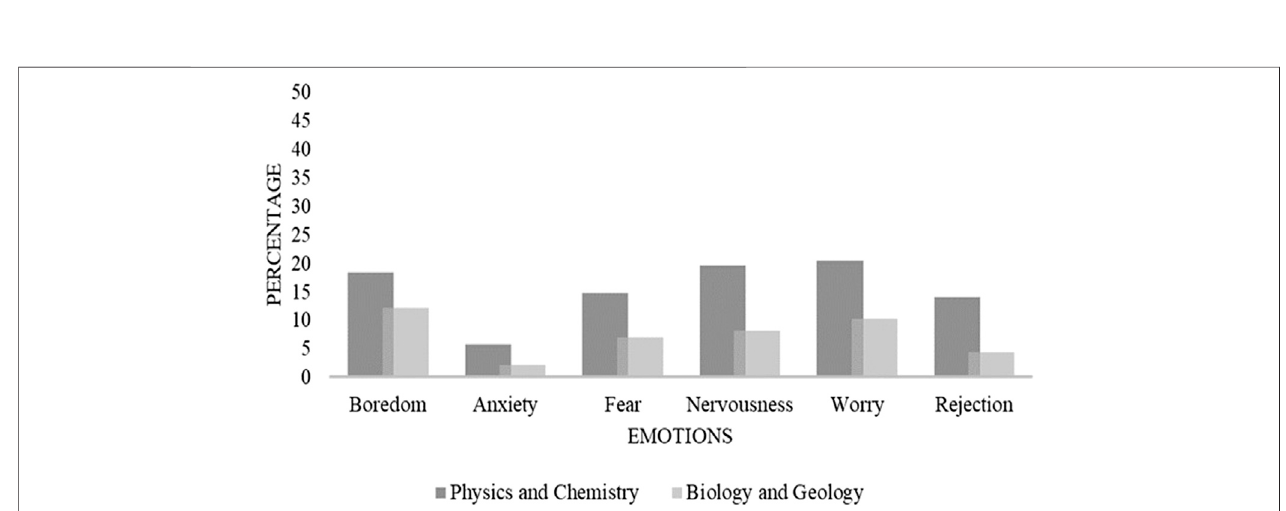
FIGURE 2 | Percentage of negative emotions toward science expressed by the prospective